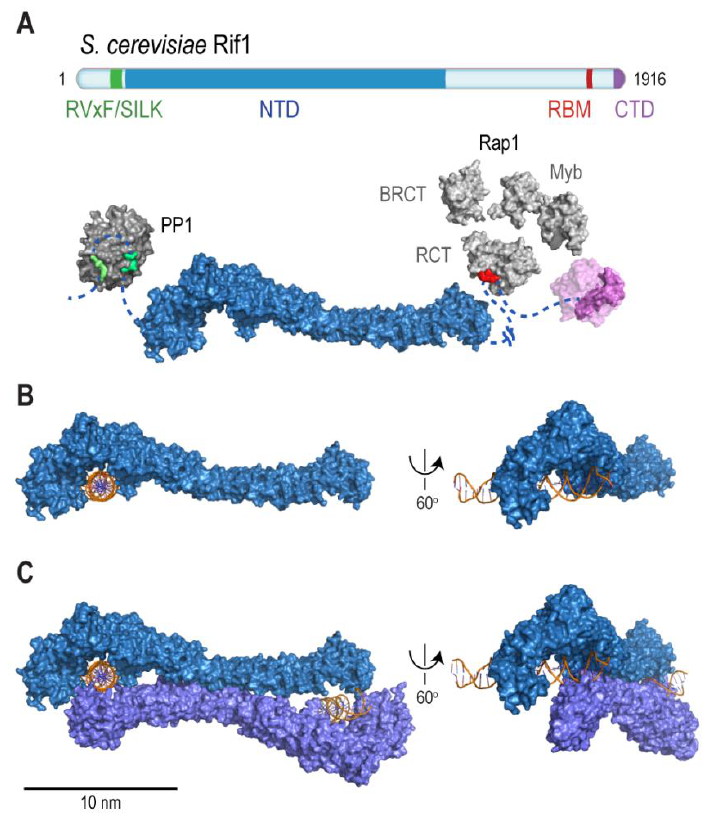
FIGURE 2: Rif1 domains and structural features. (A) Cartoon of S. cerevisiae Rif1 with structural represen- tation of the indicated domains: RVxF/SILK PP1/Glc7 interacting motifs ( green ), NTD (N-terminal domain; blue ), RBM (Rap1-binding motif; red ) and CTD (C- terminal domain; purple ). The RVxF (residues 115- 118) and SILK (residues 146-149) motifs are shown bound with protein phosphatase PP1 ( dark grey